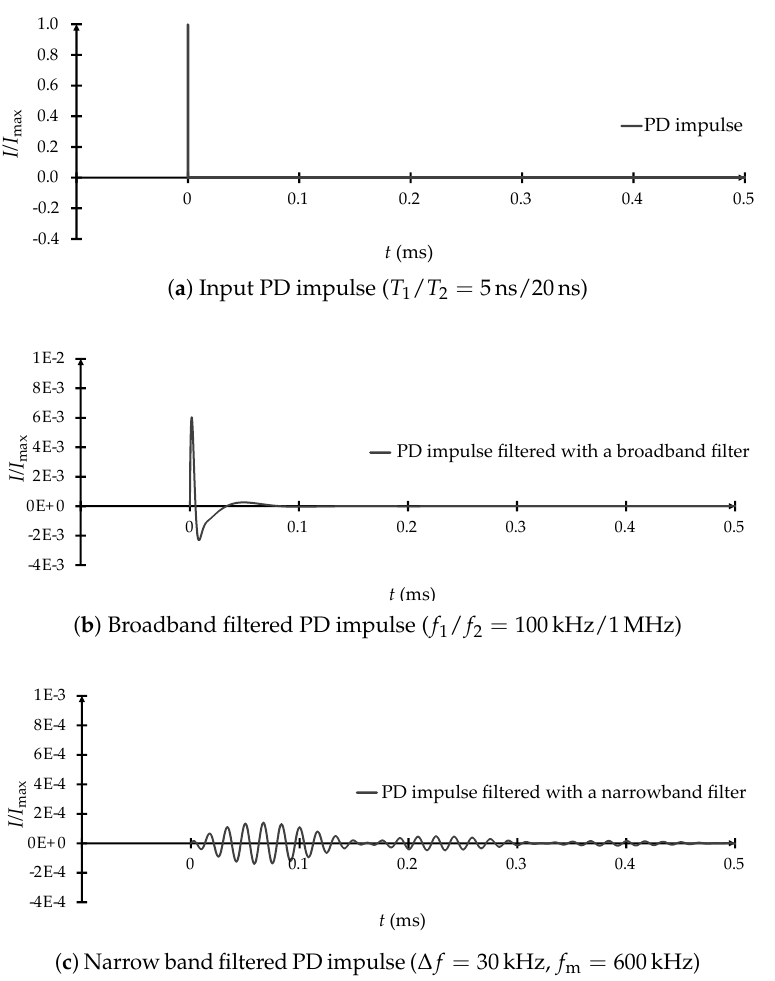
Figure 2. Influence of the filter parameters when filtering a transient signal with a Butterworth filter.